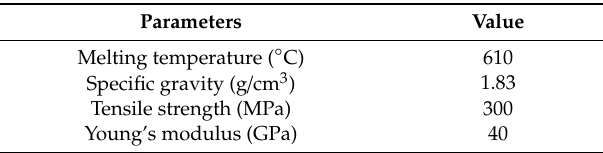
Table 1. AZ63 characteristics.